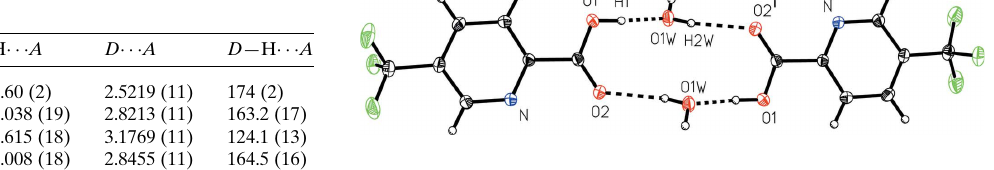
Figure 2 Aview of the intermolecular water-bridged hydrogen-bonding dimer in 5- (trifluoromethyl)picolinic acid (I) hydrate.